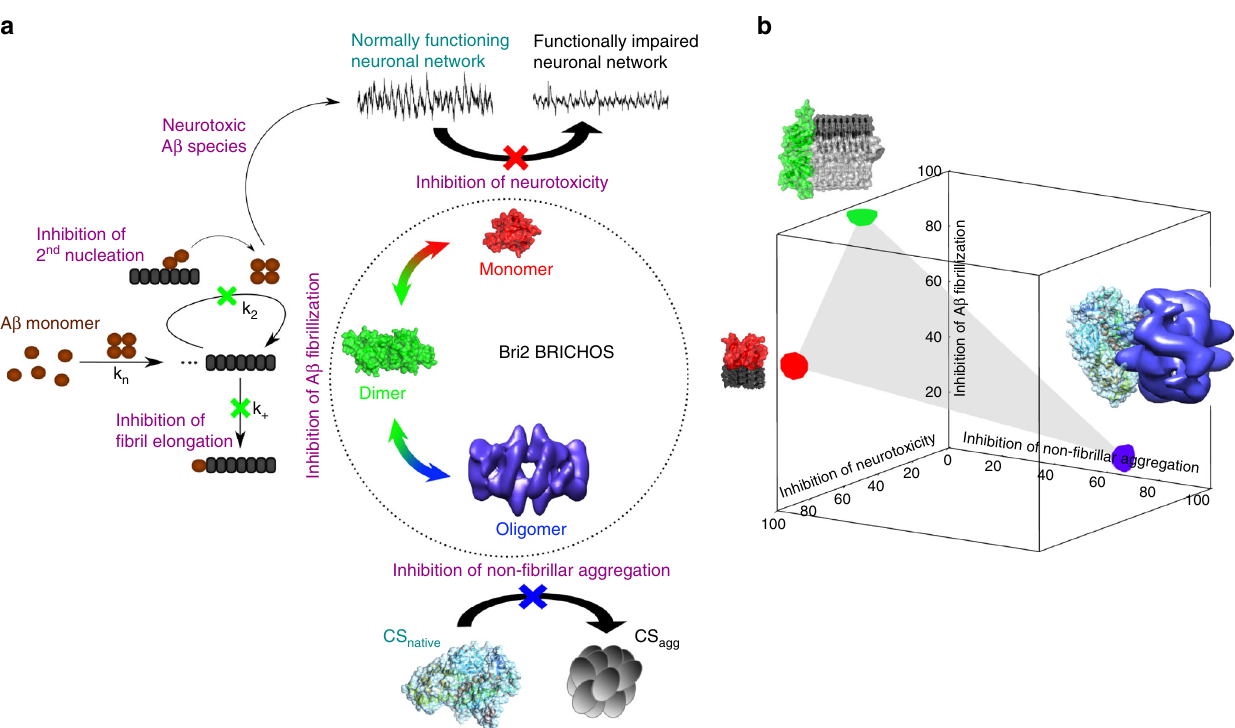
Fig. 8 Different activities of Bri2 BRICHOS are mediated by distinct quaternary structures. a Bri2 BRICHOS monomers form dimers, which are able to assemble into structured high-molecular weight oligomers. Each quaternary structure most ef fi ciently exerts one distinct function: monomers prevent A β 42-associated neurotoxicity, dimers counteract A β 42 fi brillization and oligomers inhibit non- fi brillar aggregation. The aggregation behavior of A β is governed by different microscopic nucleation events, where in particular fi bril end elongation ( k + ) and surface-catalyzed secondary nucleation ( k 2 ) are inhibited by Bri2 BRICHOS dimers. b The ef fi ciencies in inhibiting neurotoxicity ( z -axis), A β 42 fi brillization ( y -axis) and non- fi brillar aggregation ( x -axis), derived from data in Figs. 4 – 6, are plotted for each quaternary structure species. The diversity in functions fi ts with molecular sizes of the respective Bri2 BRICHOS quaternary structure compared with the sizes of their respective preferred substrate. A Bri2 BRICHOS dimer (surface area ~ 2570 Å 2 , evaluated by juxtaposing two Bri2 BRICHOS subunit models 26 , built from the proSP-C BRICHOS crystal structure (PDB 2YAD)) matches well the cross-sectional area (~ 2250 Å 2 ) of A β 42 fi brils (PDB 5KK3) that consist of two β -structured A β molecules per fi bril layer. A Bri2 BRICHOS monomer, which prevents A β toxicity to neuronal networks, fi ts well in size with single layer β -structured A β molecules that may build up oligomers. A high-molecular weight Bri2 BRICHOS oligomer (Fig. 2) that ef fi ciently suppresses thermo-induced aggregation of CS provides a large binding surface that is suited to capture native and/or partially denatured CS (illustrated by the structure of porcine heart CS, PDB